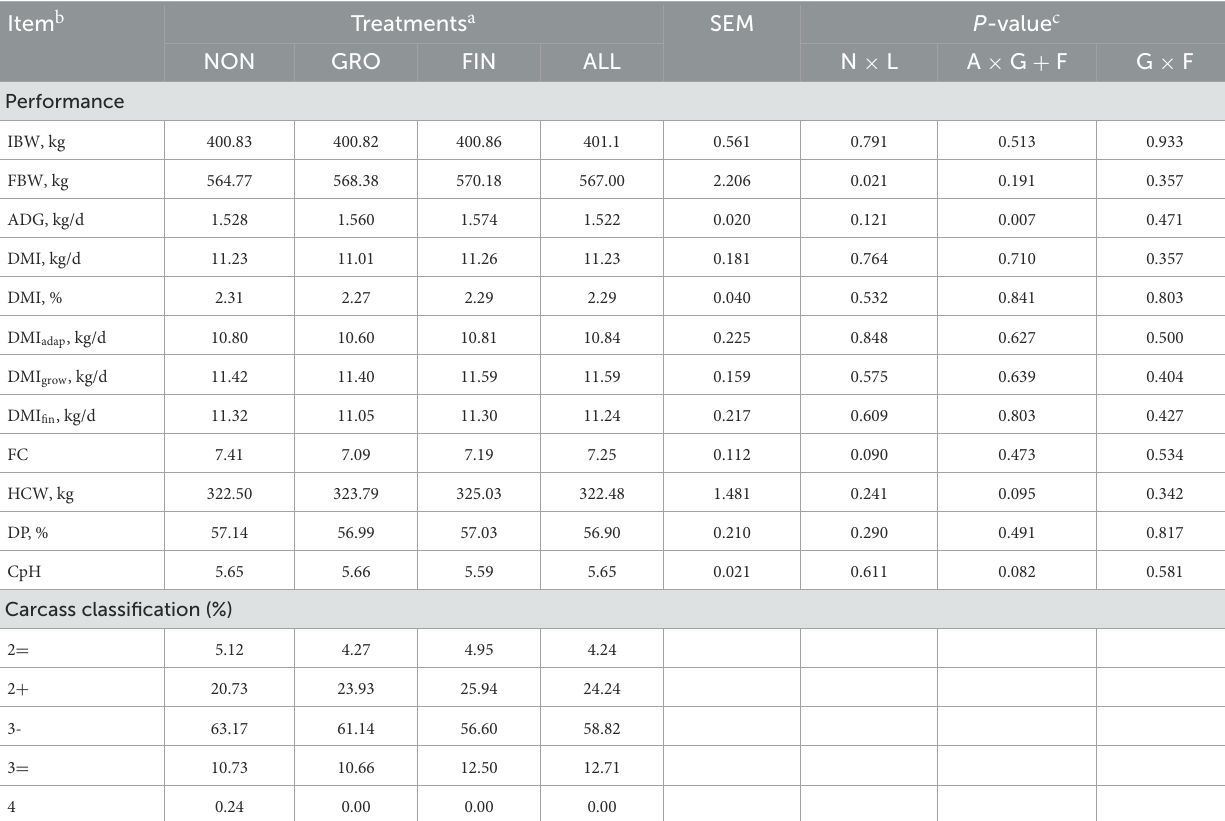
TABLE 2 Effects of lysolecithin-derived feed additive administration on the performance of Bos indicus influenced cattle in Experiment